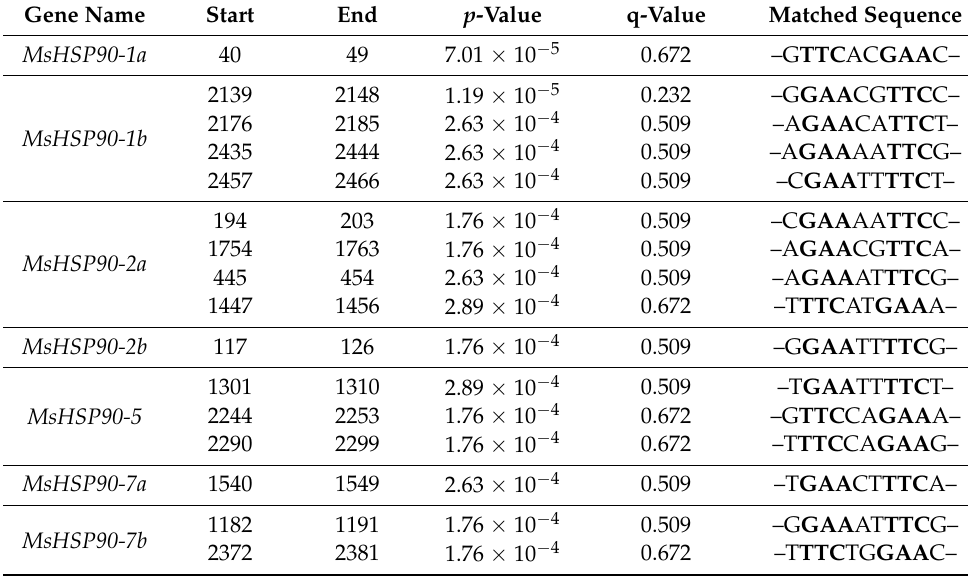
Table 2. The list of HSE motifs identified in the promoters of MsHSP90 genes.